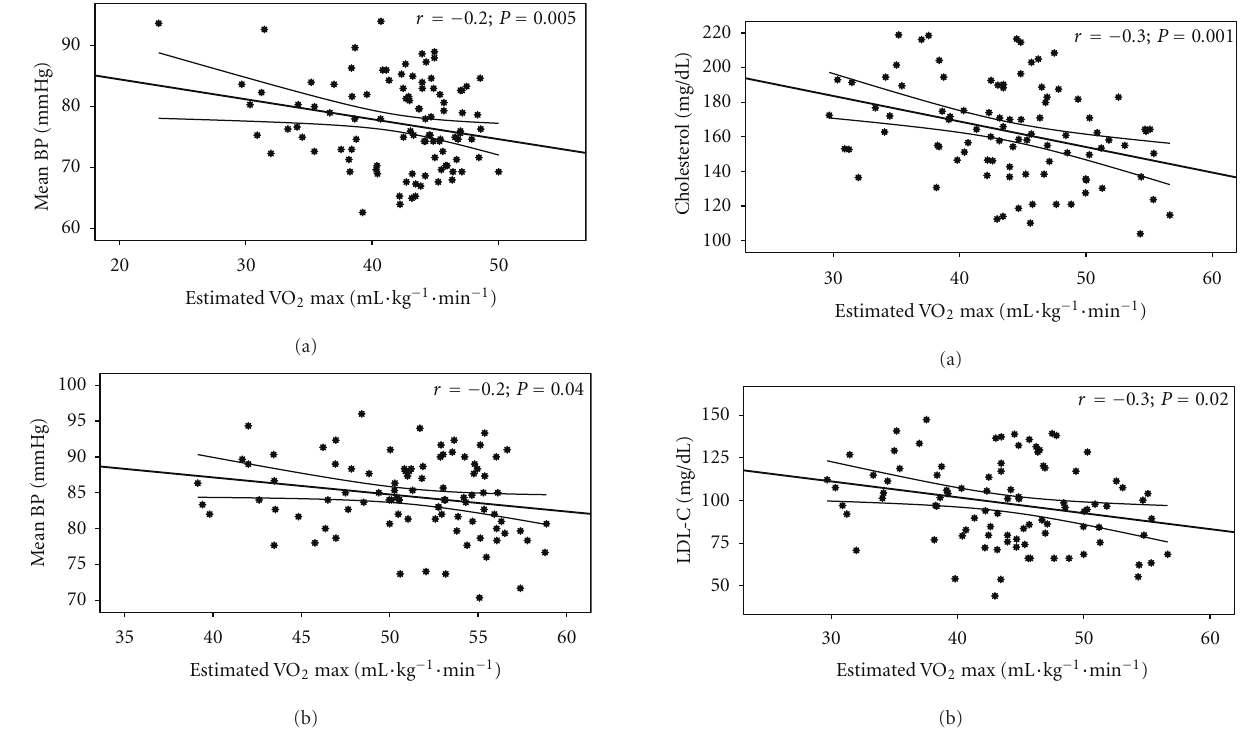
Figure 6: Estimated VO 2 relationship with cholesterol (a) ( r = − 0 . 3; P = 0 . 001) and LDL-C (b) ( r = − 0 . 3; P = 0 .